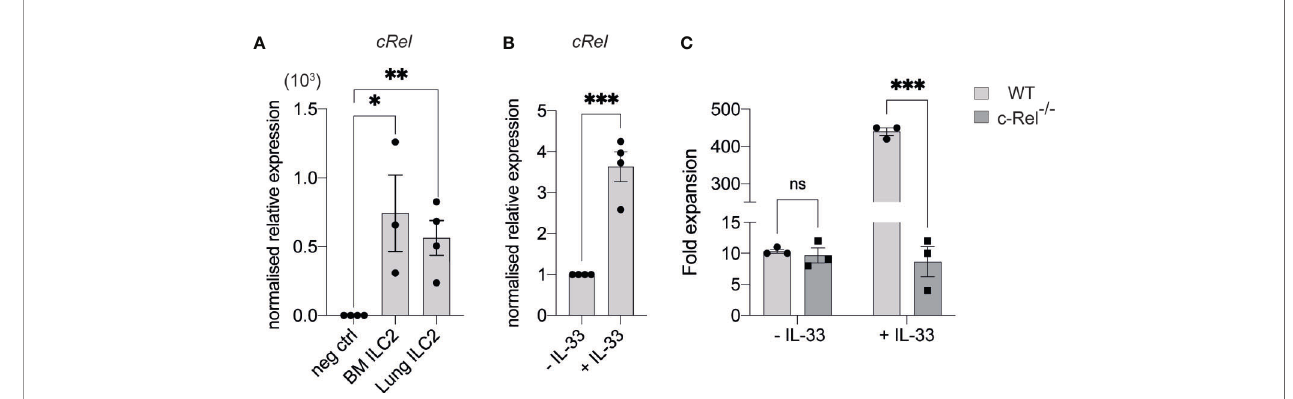
FIGURE 3 | c-Rel is required for IL-33-dependent expansion of ILC2s. (A) qPCR analysis of cRel in ex vivo FACS-sorted BM-derived ILC2 and lung-derived ILC2 from naive WT mice (fold change over negative control). (B) qPCR analysis of cRel in BM-derived ILC2 cultures restimulated with IL-33 for 6 h. (C) Quanti fi cation of fold expansion derived from cell count on ex vivo BM-derived ILCP cultures. FACS-sorted BM ILC2Ps were cultured in ILC media in the presence of IL-2, IL-7 and IL-25 for 14 days. On d15, expanded cells were cultured in only IL-2 and IL-7 overnight. On d16, expanded cells were re-stimulated with or without IL-33 (control) for 6 h, followed by cell count. All plots and graphs are representative of at least two independent experiments with at least three mice per group. Error bars represent ± SEM. *p ≤ 0.05, **p ≤ 0.01, ***p ≤ 0.001. ns, non-signi fi